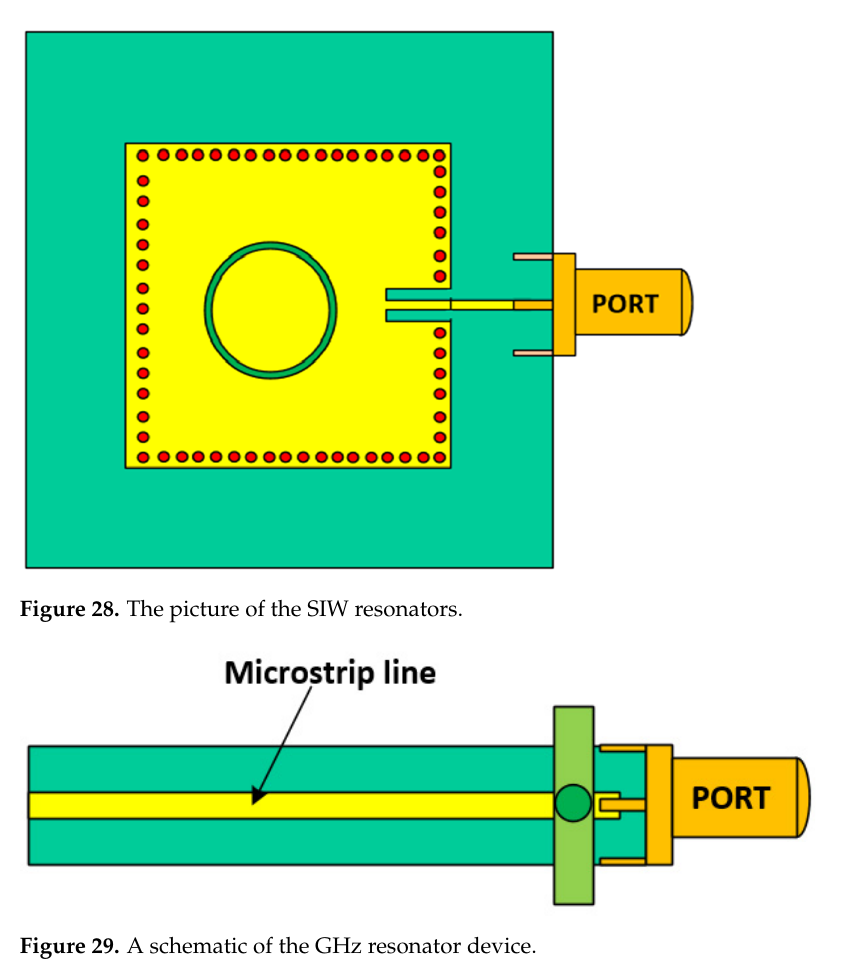
Figure 29. A schematic of the GHz resonator device.